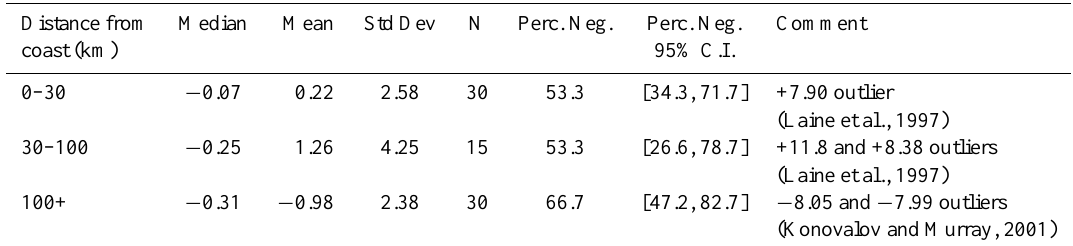
Table 4. Oxygen trend statistics (µmolL − 1 yr − 1 ) for published time series in various ranges of distances from the coast, for the 1976–2000 period. Abbreviations: C. I. = confidence interval; Std Dev = standard deviation; N = number of time series; Perc Neg = Percentage of negative